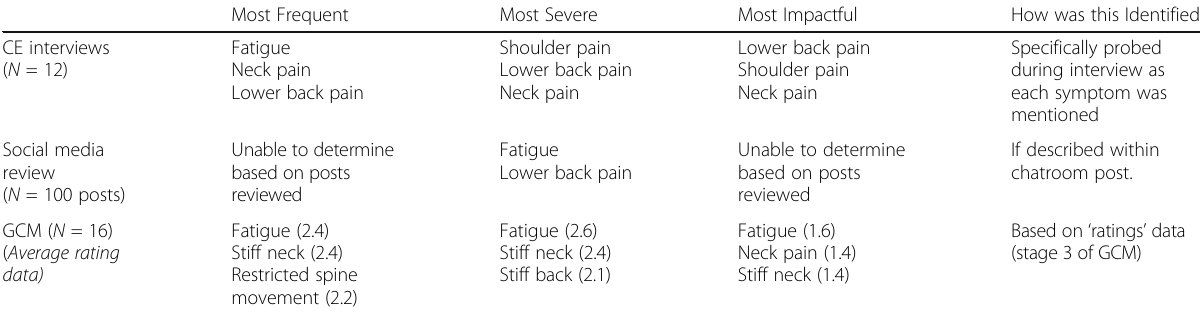
Table 4 Comparison of methods according to the most severe, frequent, and bothersome AS symptoms